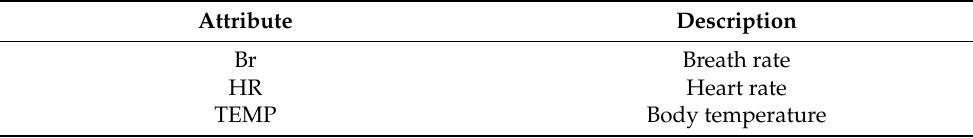
Table 10. Some of the input attributes used for model formation and validation.